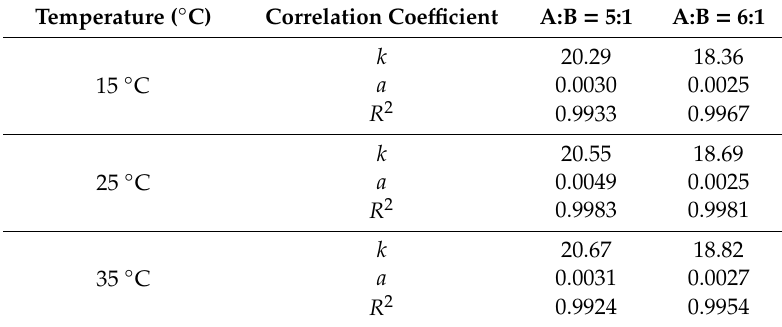
Table 2. The undetermined coe ffi cient and correlation coe ffi cient of rheological properties fitting function of slurry at di ff erent